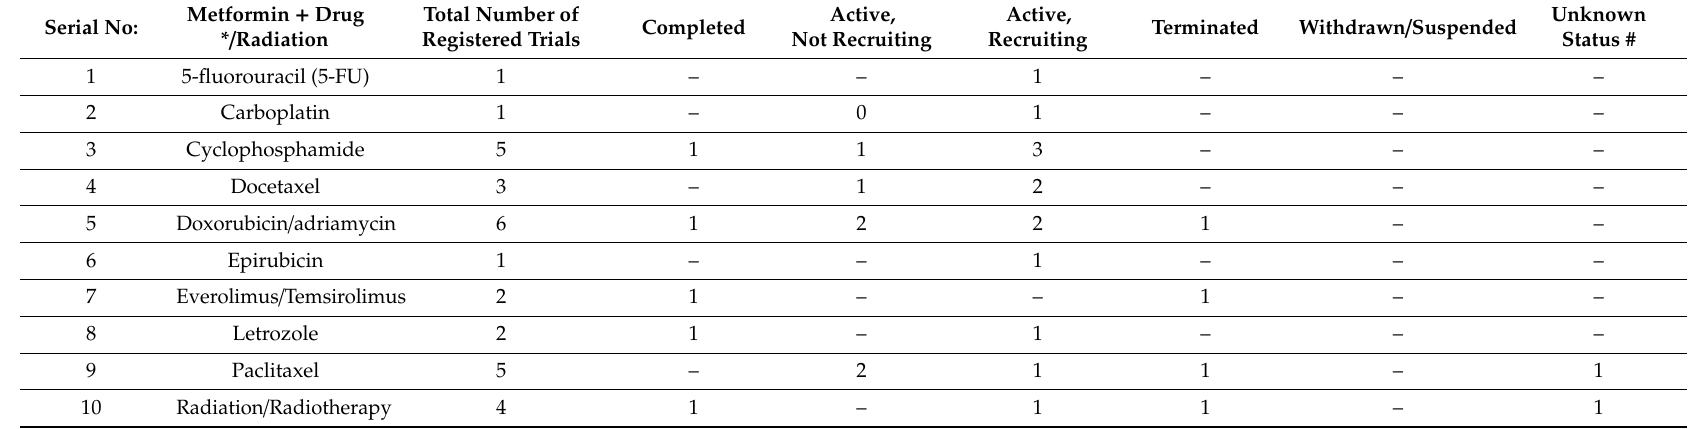
Table 3. Status of metformin and drug / radiation-related clinical trials in breast cancers (https: // clinicaltrials.gov /